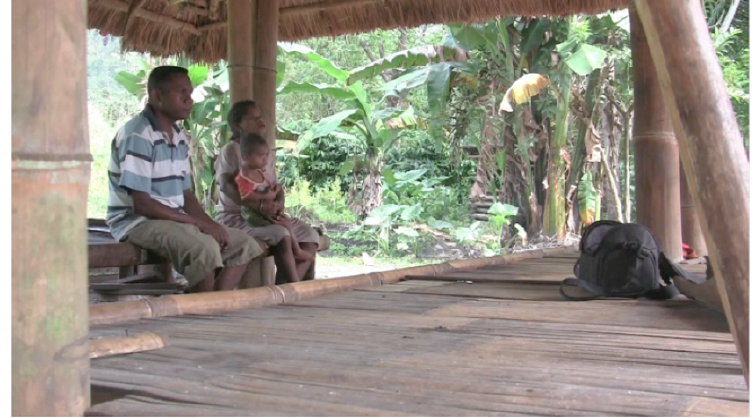
Figure 4. Matilda and Peny conversing with Isakh